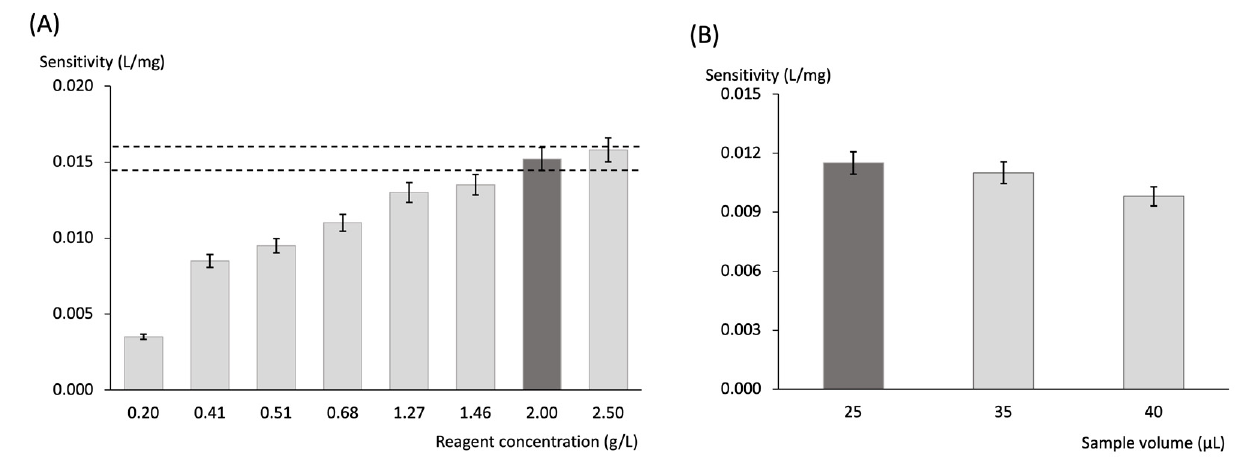
Figure 4. Study of the influence on the calibration curve slope by different concentrations of ligand solution ( A ) and by different sample/standard volumes ( B ); the dark grey bars represent the chosen option; the black horizontal lines represent the range of the error bars with 5% deviation of the measurements.